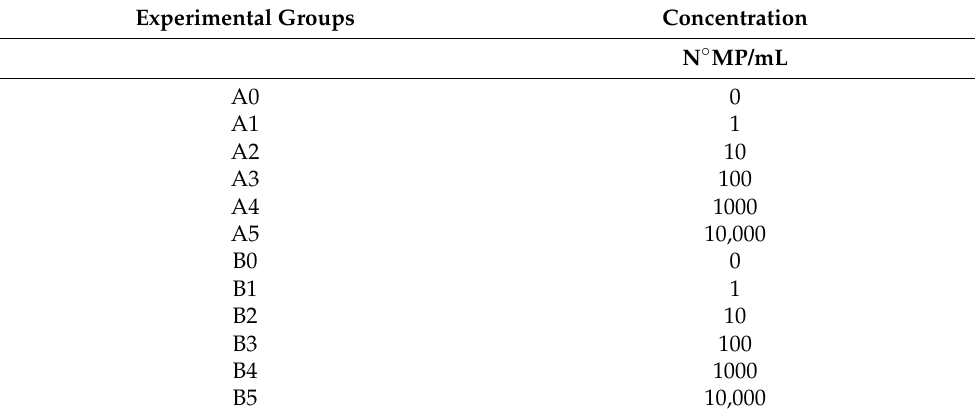
Table 1. Experimental Treatments